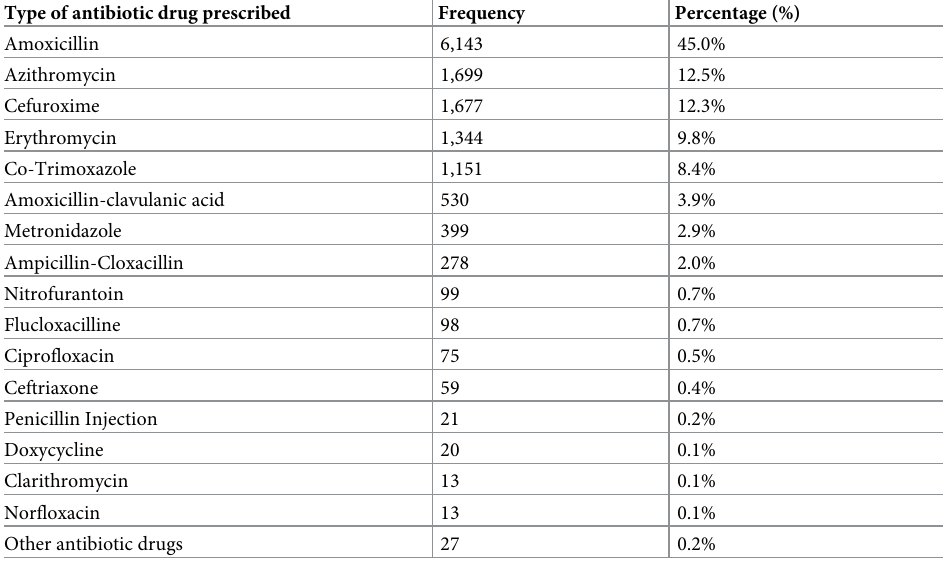
Table 6. Ranking the frequency of antibiotic drug prescriptions for the treatment of ARIs at the study clinics between April 1 and December 27, 2016, in Nairobi, Kenya (N = 13,646). Type of antibiotic drug